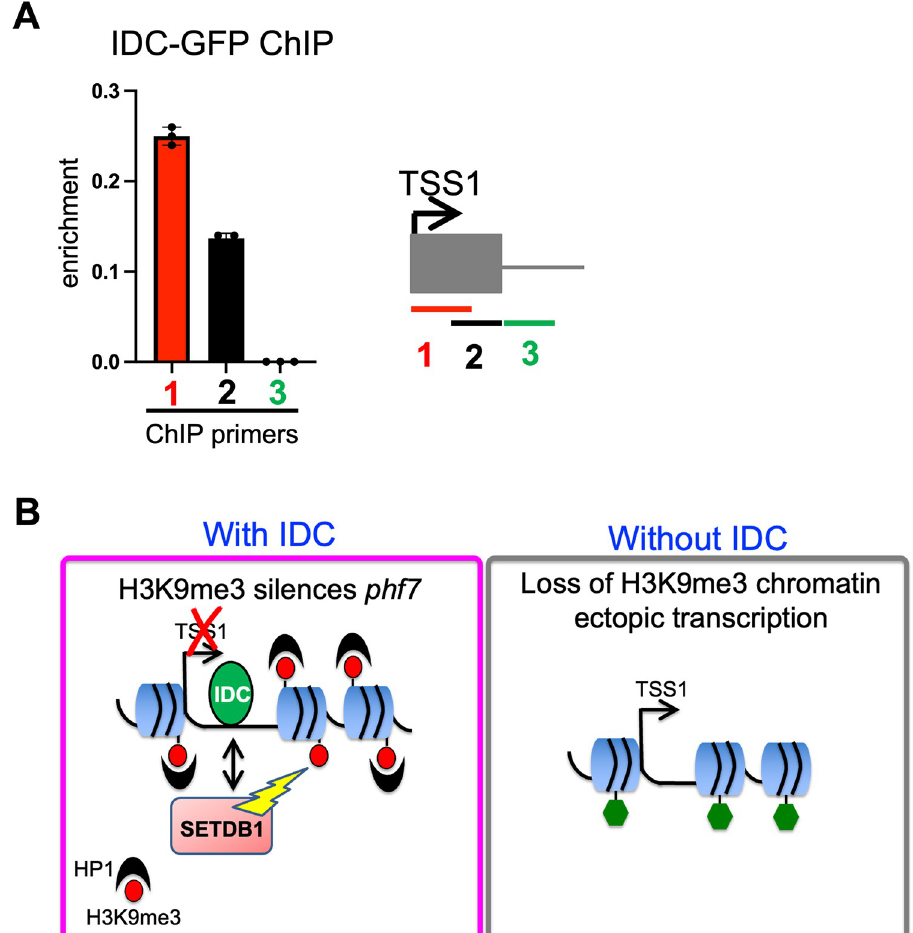
Fig 7. IDC binds to phf7 . ( A) ChIP-qPCR shows that IDC binds to the phf7 first exon. Left: The histogram shows the mean ± SD of three biological replicates. Right: Cartoon showing the location of the primers used for ChIP-qPCR. (B) Model for H3K9me3-mediated silencing of phf7 . In female germ cells, IDC binds to phf7 , directing H3K9me3 deposition by SETDB1 H3K9 methytransferase. HP1 binds to H3K9me3, resulting in transcriptional silencing. In germ cells lacking IDC, the dissolution of the H3K9me3 domain correlates with ectopic testis-specific phf7-RC transcription and PHF7 protein expression. Ectopic PHF7 activates a toxic gene expression program enriched for genes usually restricted to the male